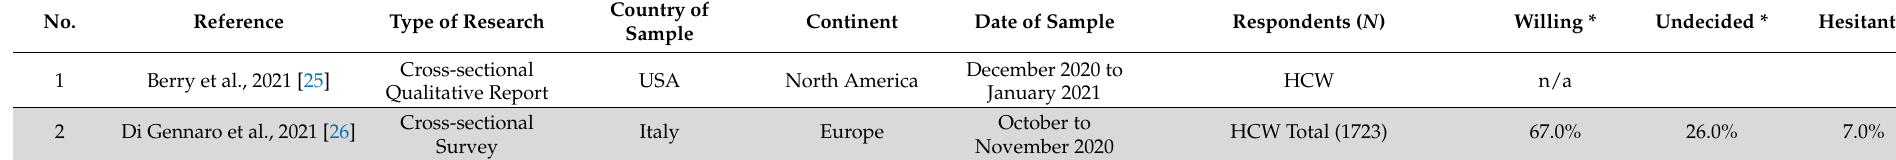
Table 1. Characteristics of selected